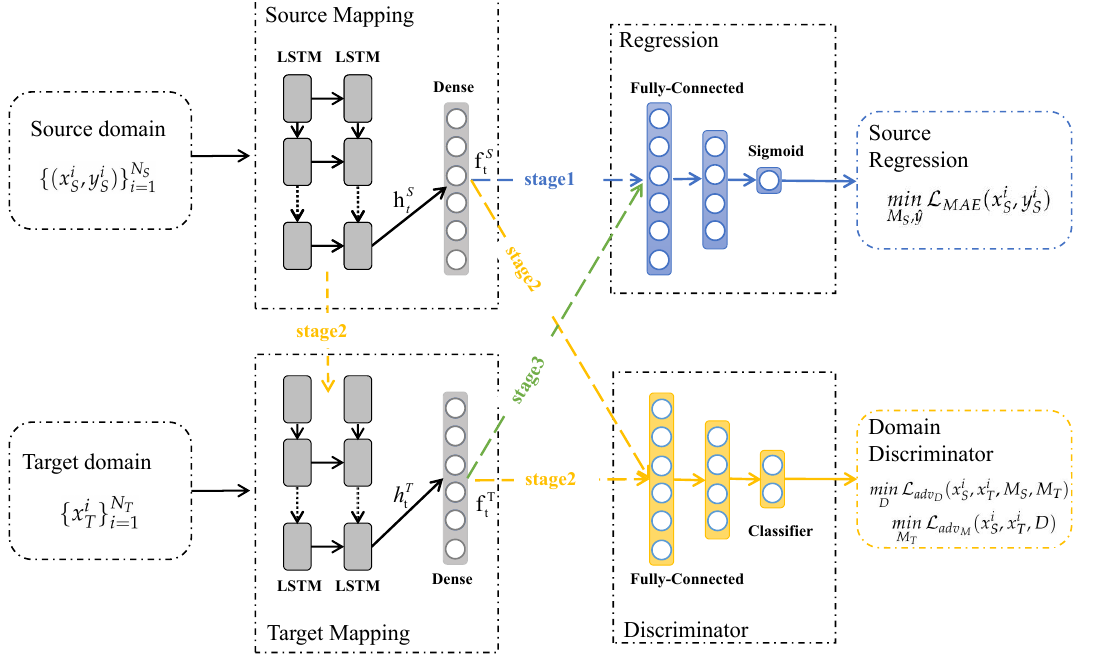
Figure 3. The network structure of the proposed LSTM-ADDA method. The data mapping structure consists mainly of the LSTM network, and the output of the last time step is input to the dense layer to obtain the domain deep feature representation. The regressor and the domain discriminator consist of fully-connected network for obtaining the RUL prediction and domain adversarial training, respectively.